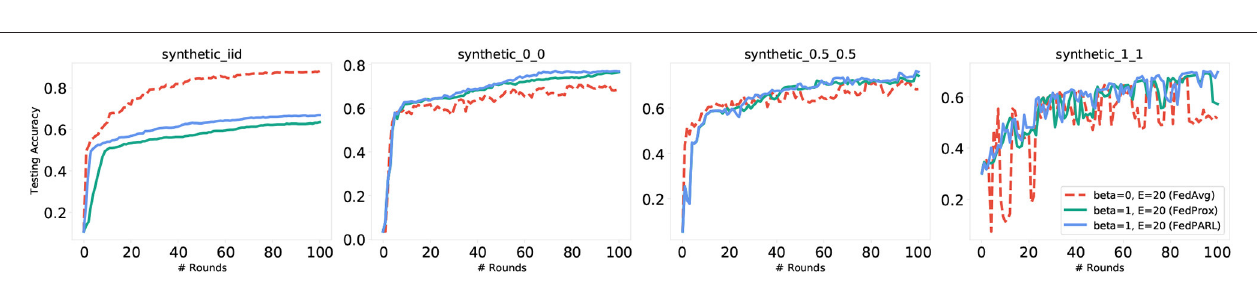
FIGURE 14 | Simulation of data heterogeneity effects on training loss by considering four synthetic datasets. From left to right, the statistical heterogeneity increases.